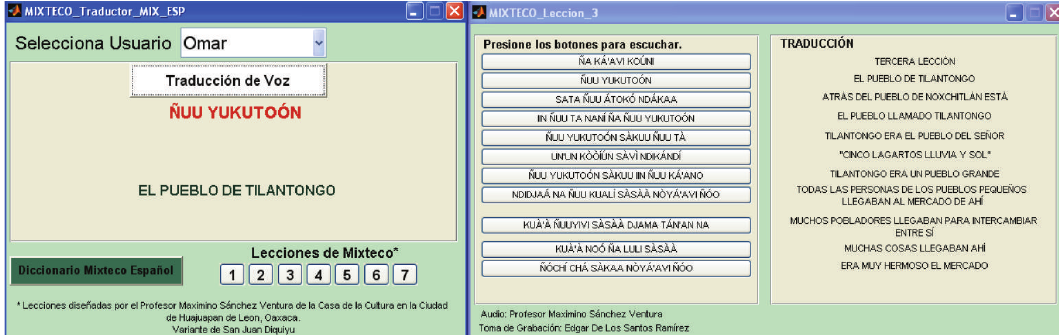
Figure 16: Mixtec-to-Spanish speech translator.